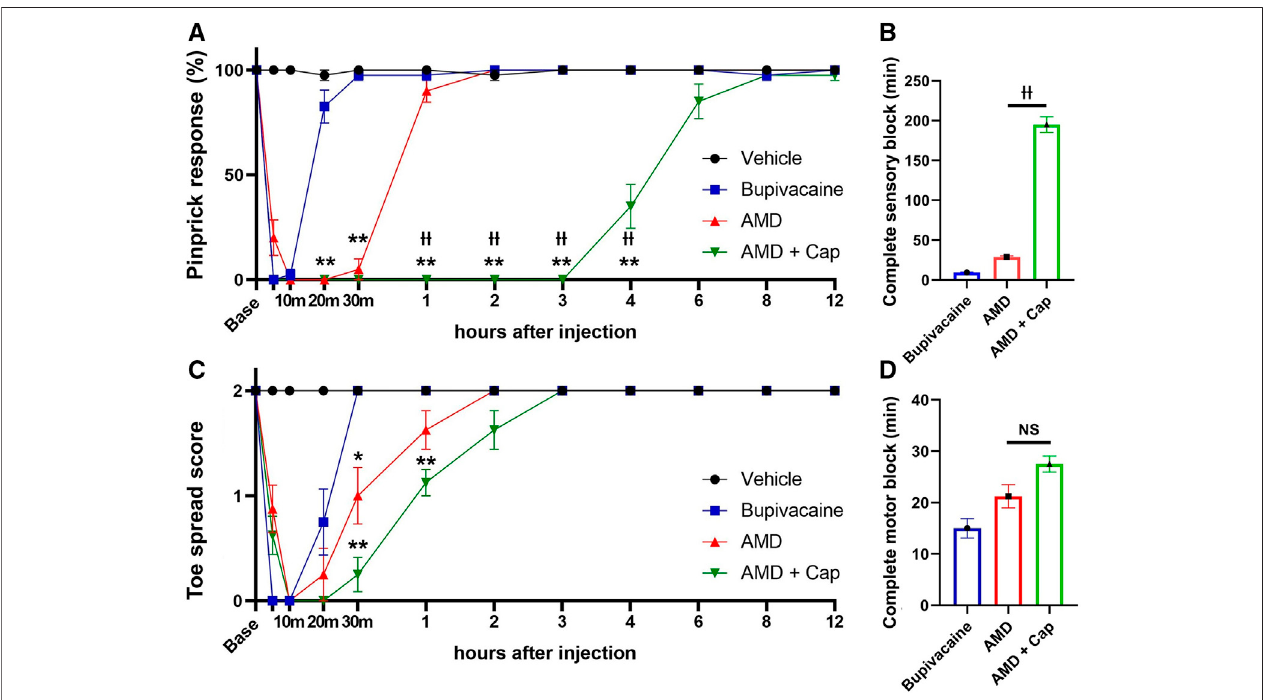
FIGURE 1 | Sensory and motor blockade after peri-sciatic nerve injection using the pinprick and toe spread tests ( n = 8 each). (A) Pinprick response rate. (B) Duration of complete sensory block de fi ned as the pinprick response rate of 0%. (C) Toe spread score. (D) Duration of complete motor block de fi ned as the toe spread score of 0. AMD: amiodarone; Cap: capsaicin * p < 0.05 vs. bupivacaine; ** p < 0.01 vs. bupivacaine †† p < 0.01 vs.